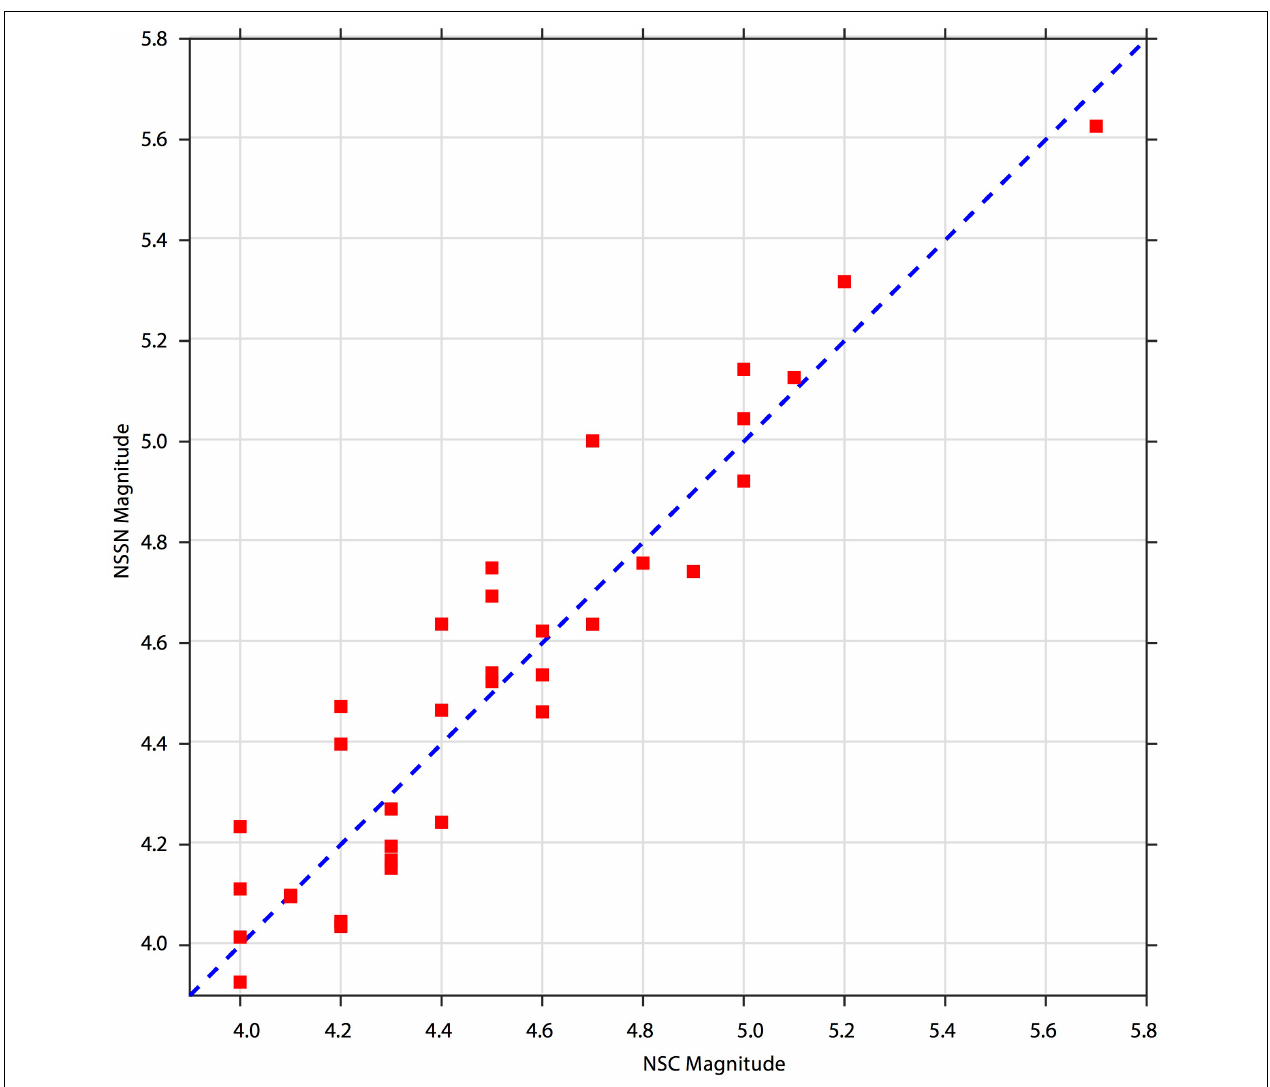
FIGURE 13 | Magnitude comparison plot. The NSC-reported magnitude is plotted against the NSSN magnitude using the newly calibrated magnitude equation (Eq. 3). Note that the site effect at each NSSN station is considered as described in the text. The maximum difference between the two magnitude scales for any given event is < 0.3 unit of M L